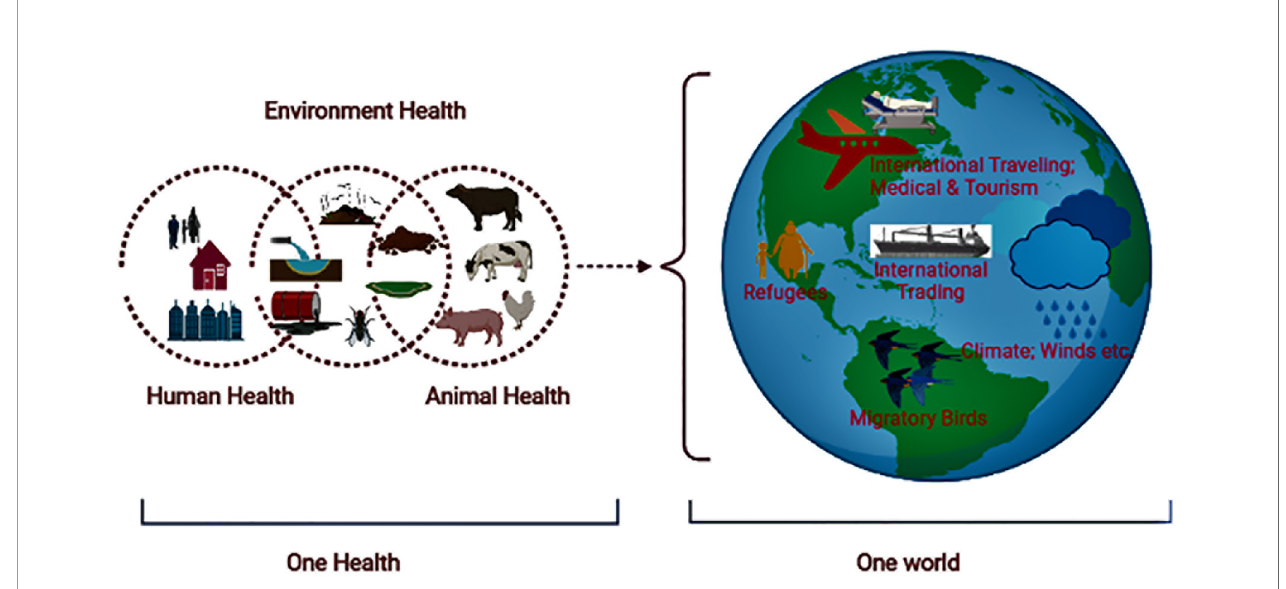
FIGURE 3 | Illustration showing the ABR in a One Health One World